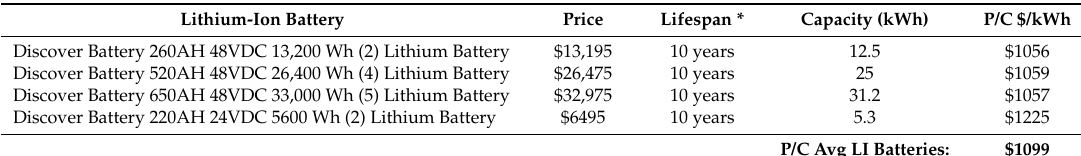
Table A6. Price per capacity scaling factor calculations for batteries.